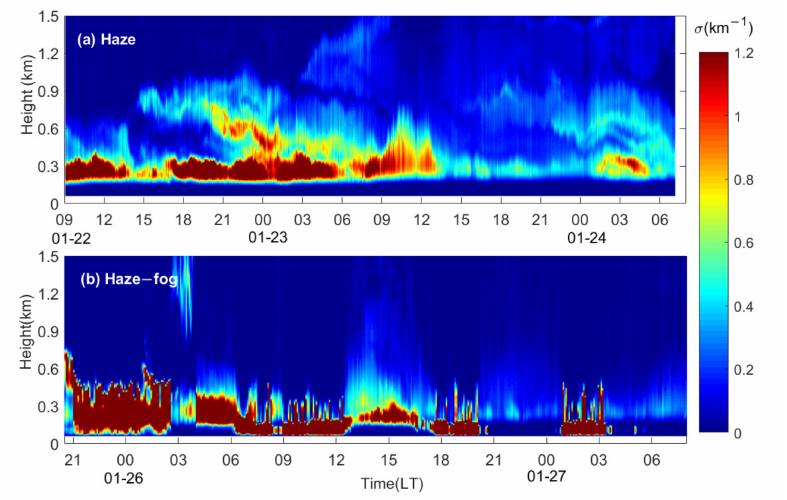
Figure 7. Vertical distribution of the aerosol extinction coefficient ( σ ext ) observed by a ground-based LiDAR at the IAE station in Shenyang ( a ) from 09:00 LT on 22 January to 07:00 LT on 24 January and ( b ) from 20:30 LT on 25 January to 08:00 LT on 27 January